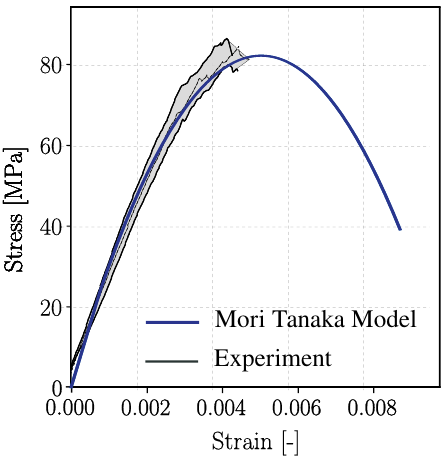
Figure 12. Comparison of the calibrated stress–strain curve with the experimental data of a mortar sample ( ϕ quartz = 30.34%). The micromechanics based model predicts the initiation of microcracking in mortar sample at a strain level of 8 × 10 − 4